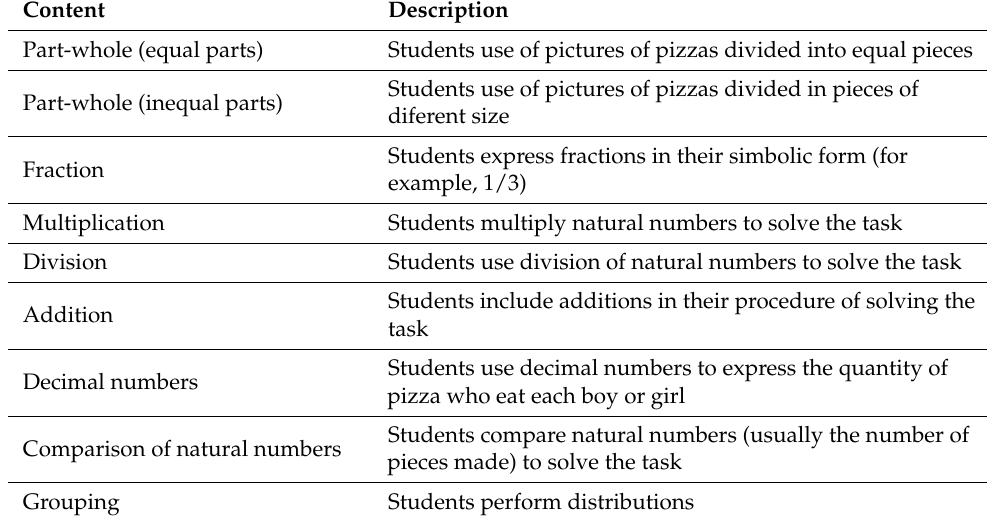
Table 2. Categories obtained after analysing contents.